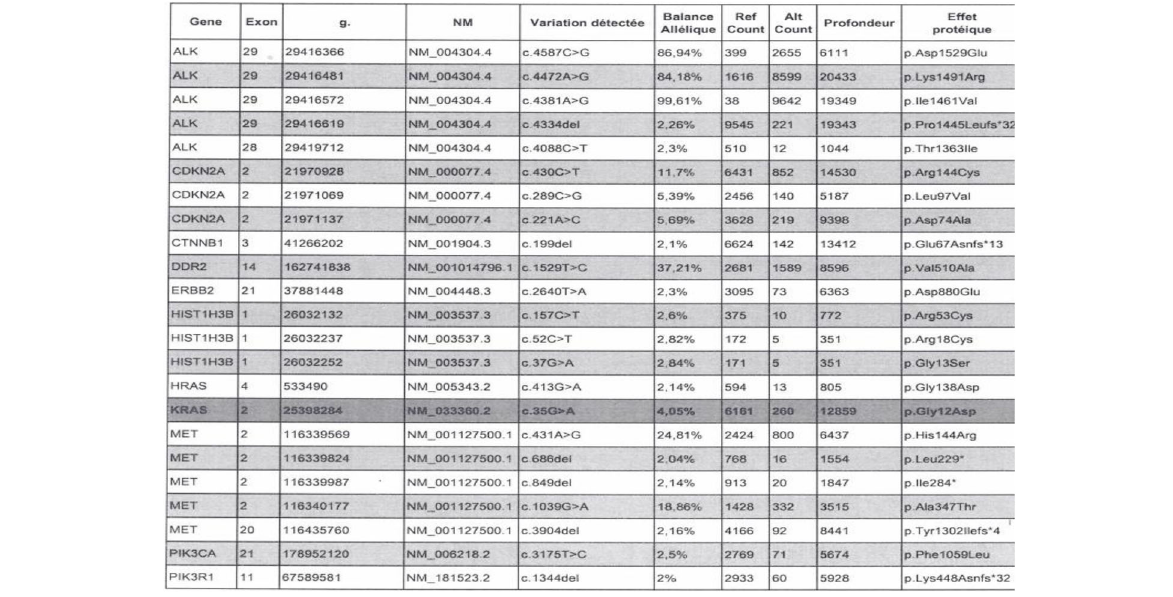
Fig. 3 List of mutations found in the teratomatous LAMN. Among the mutations revealed in the LAMN lesion, there was a c.35G > A mutation in KRAS gene corresponding to a p.(Gly12Asp) protein effect (highlighted